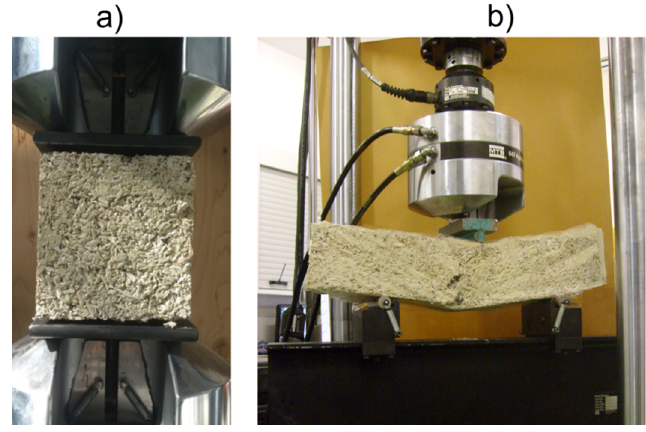
Figure 4. Composite mechanical properties determination: ( a ) compressive strength test, and ( b ) flexural strength test.